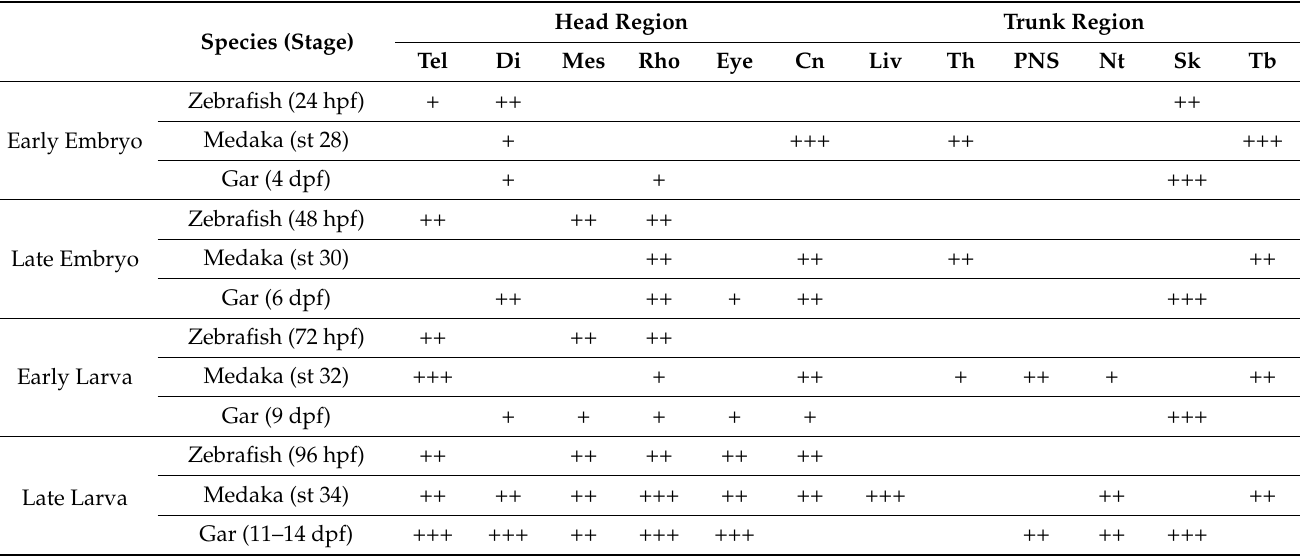
Table 1. Comparative analysis of nos1 expression territories in zebrafish, medaka, and spotted gar. Head Species (Stage)